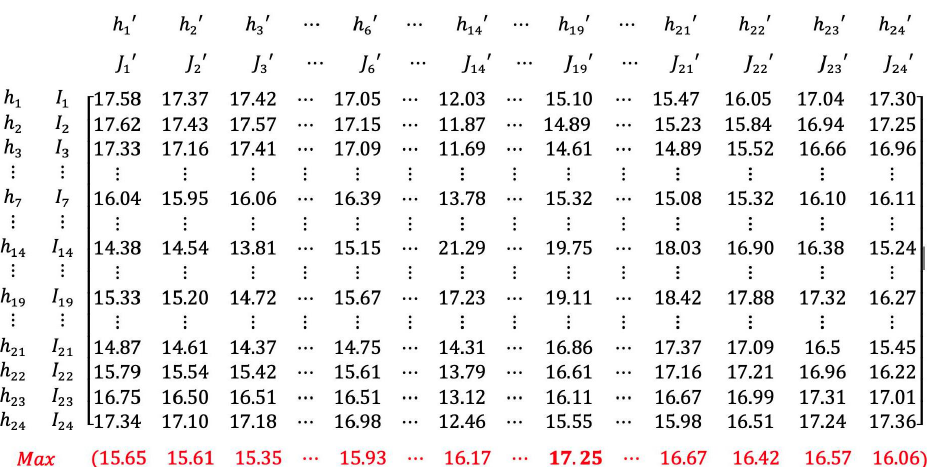
Figure 3. A Matrix Showing the Whole Process of the OSTO on the Case in Washington DC (k = 100). All numbers in Figure 3 are percentages. Numbers in black show the AED coverage rate when apply- ing the solution in a specific hour (e.g., J (cid:48) ) to cover a visitor distribution at all hours (e.g., h 1 , h 2 , ..., h 24 ). 1 ) of each solution. The number marked in Numbers in red show 24 of the average performances ( N J (cid:48) h (cid:48) red bold is the highest average performance 17.25% (when J (cid:48) is applied to all 19